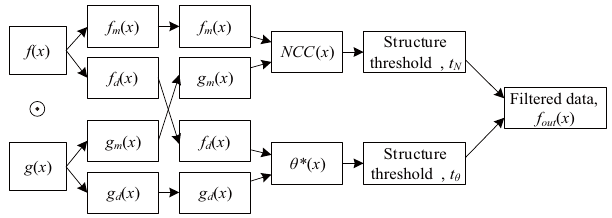
Fig. 1. The procedure of the template-based structure